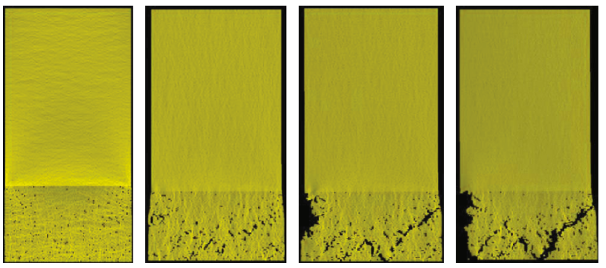
Figure 5: Fracture process of SCR70 sample.